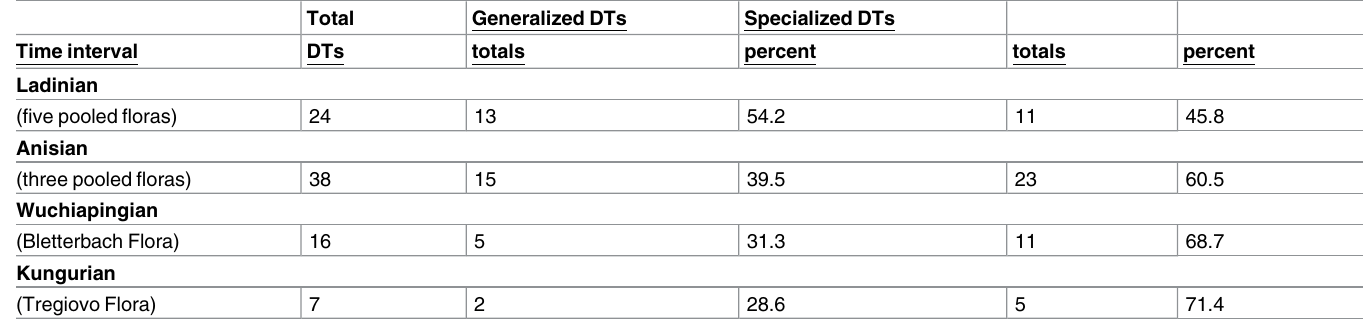
Table 1. Damage type (DT) diversity and generalization–specialization proportions for the four major floras